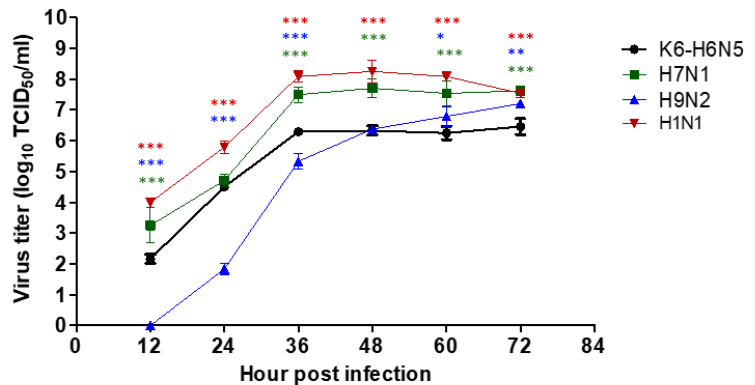
Figure 2. In vitro growth properties of H6N5 in MDCK cells. Viruses were inoculated into MDCK monolayers at a multiplicity of infection (MOI) of 0.01. The supernatants were collected at different time points: 12, 24, 36, 48, 60, and 72 hours post infection (hpi). Viral replication titers were determined by TCID 50 assay. *, p < 0.05; **, p < 0.01; ***, p < 0.001.